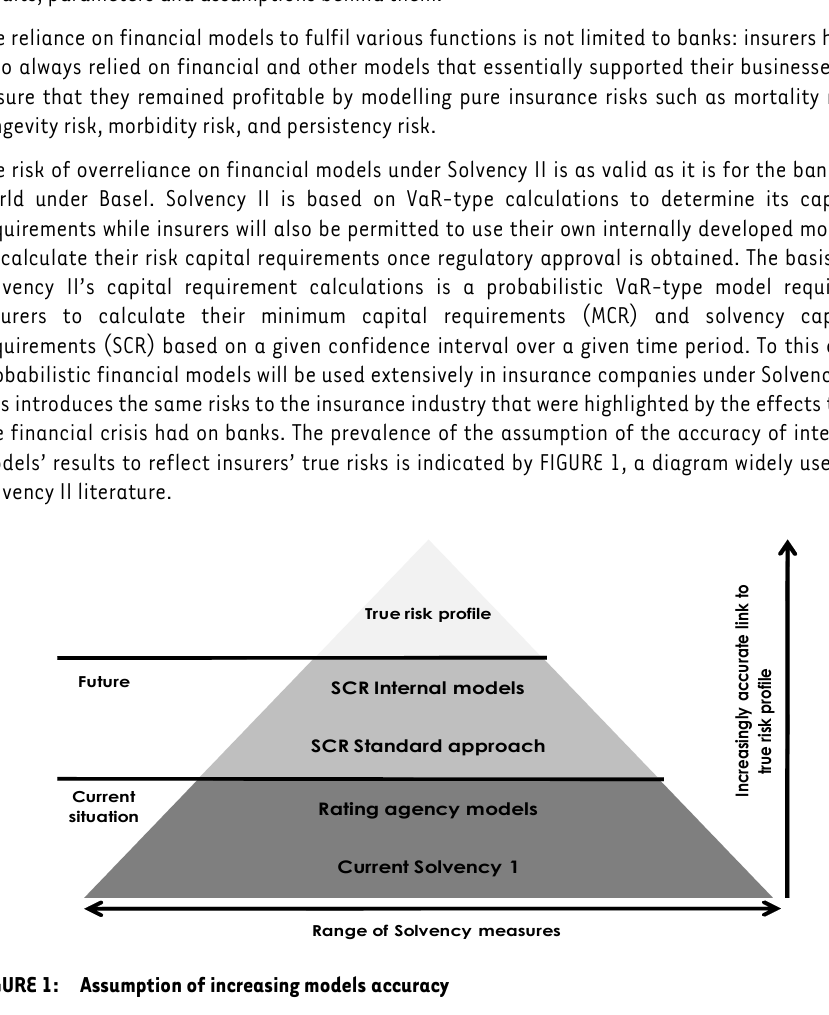
FIGURE 1: Assumption of increasing models accuracy Source: CEA